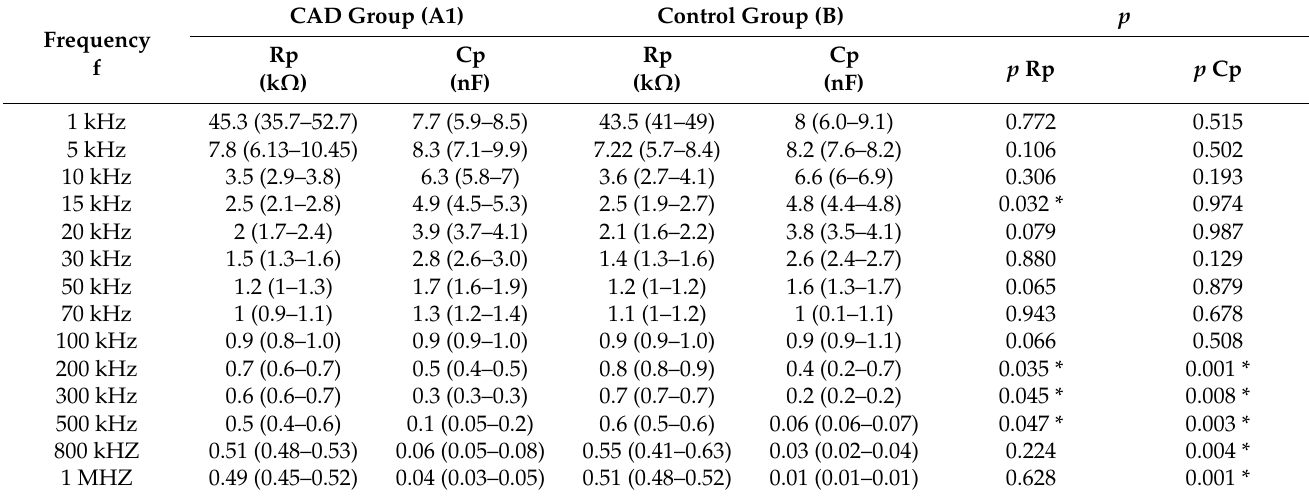
Table 3. EIS measurements comparison between CAD (A1) and control (B)